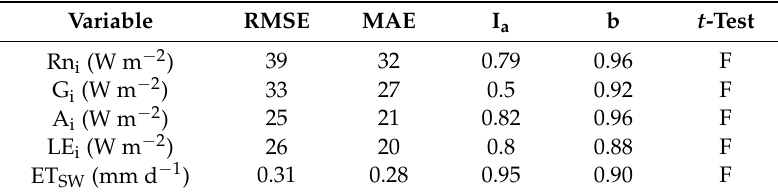
Figure 4. Comparison between estimated and observed values of daily actual evapotranspiration of a drip irrigated olive orchard. ( ET (cid:2929)(cid:2933) ). Index of agreement ( I (cid:2911) ) for ET (cid:2929)(cid:2933) was equal to 0.95. This comparison was done using days when satellite images were available.